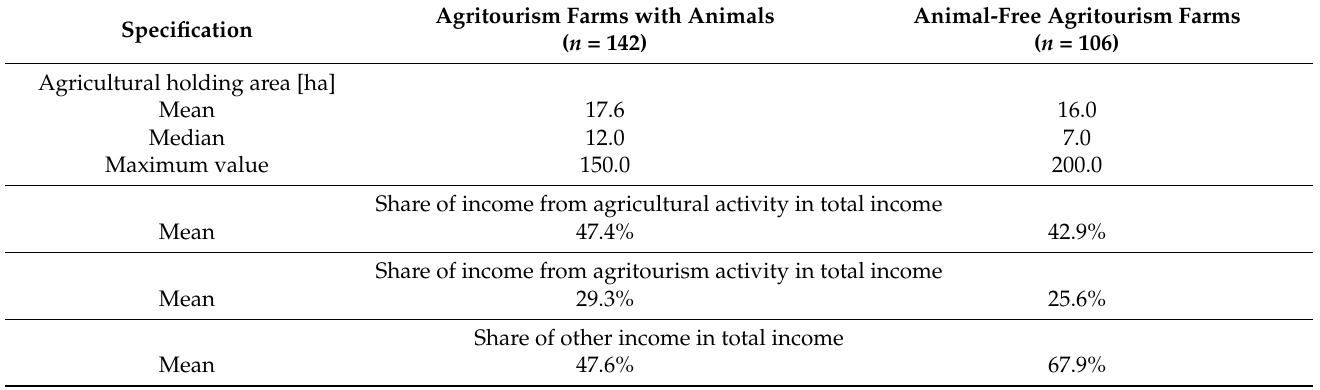
Table 1. Characteristics of the surveyed agritourism